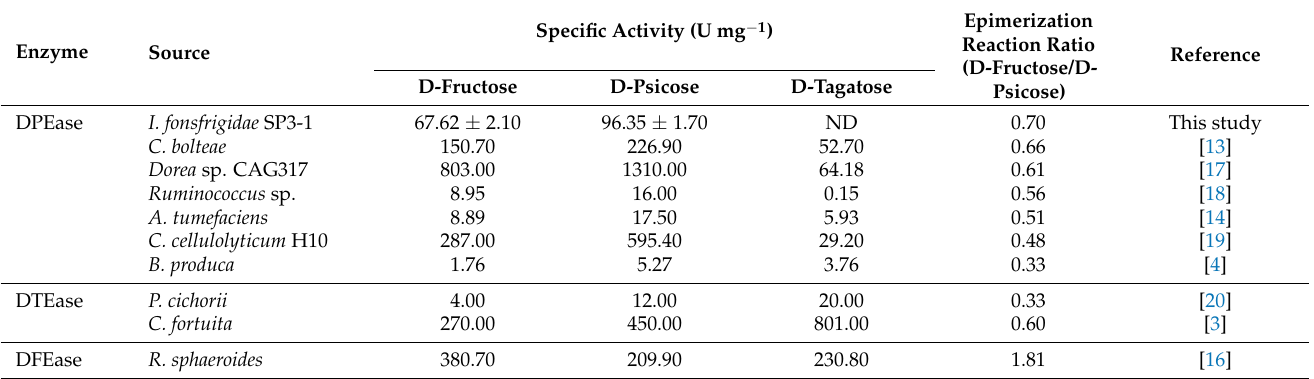
Table 3. Comparison of specific activity of ketose 3-epimerases from various microorganisms.